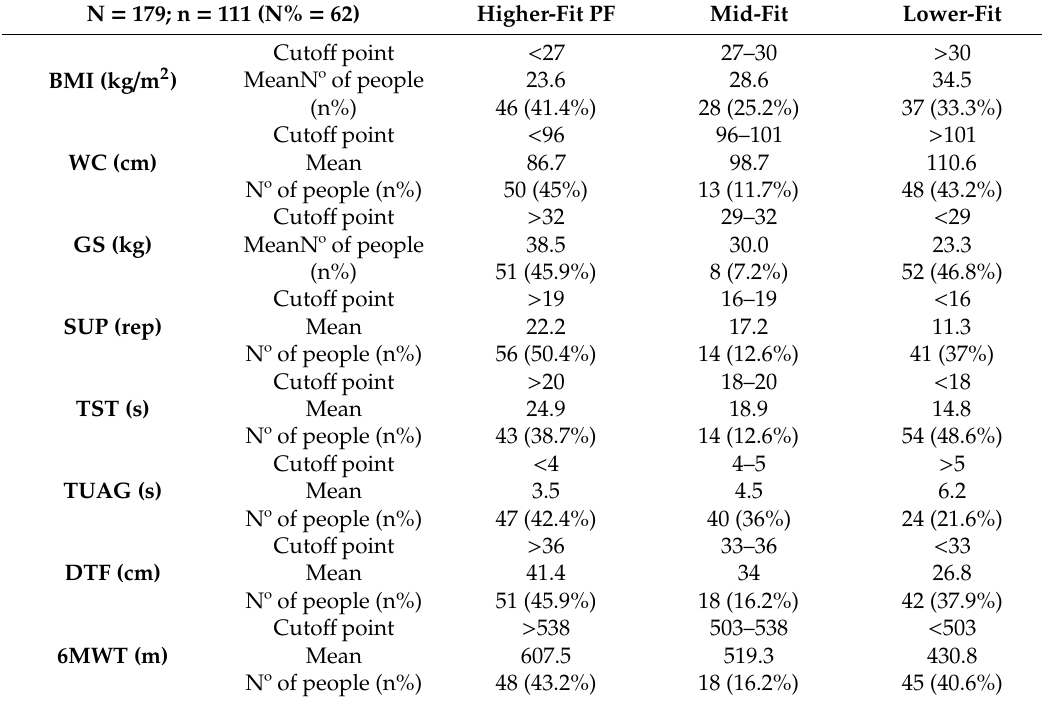
Table 2. Middle-aged men (30–50 years old) results for each variable categorized in 3 physical fitness